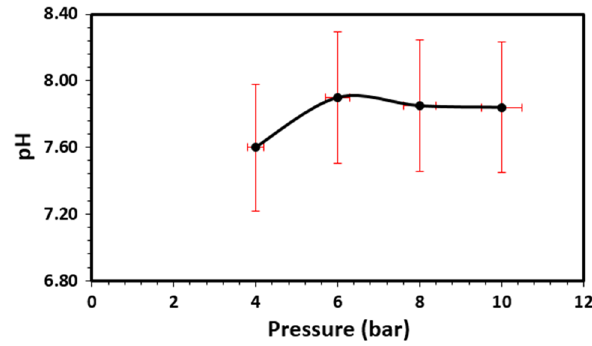
Fig. 8 Effect of different applied pressures on the treatment of the Red Sea water in membrane #2 (ES404)